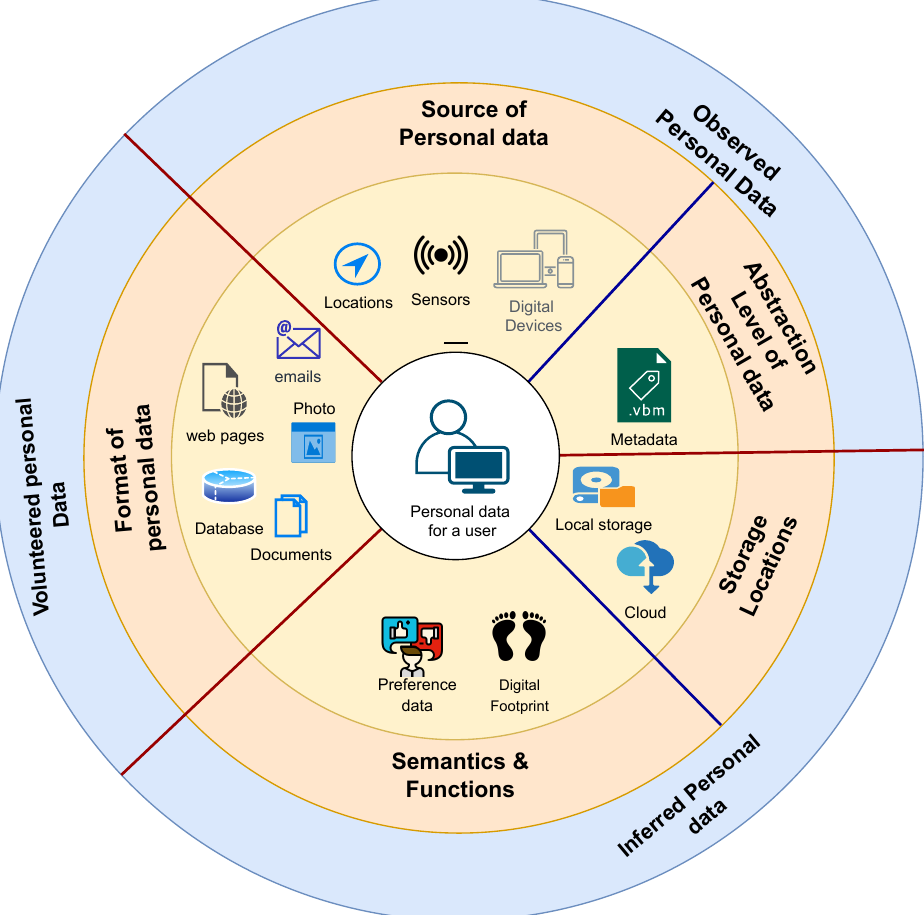
Figure 1. Two levels of classification of Personal Data (PD) [15,16]. Level one involves volunteered data (intentionally created by a user), Observed PD (created automatically about a user), and Inferred PD (generated after computational analysis). Level two involves format, source, abstraction level, storage location and semantics, and functions of